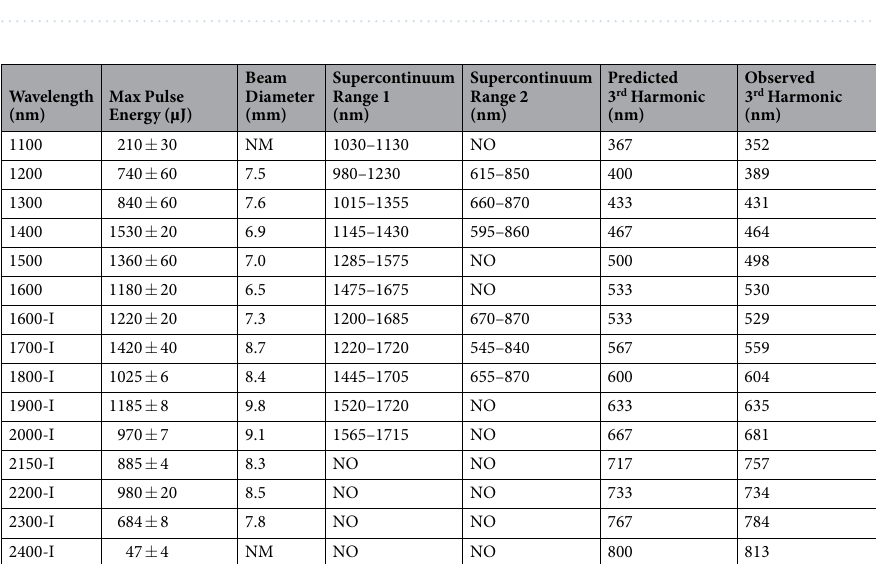
Table 2. Beam parameters for spectra generation. Wavelengths followed by “-I” were generated using the Idler beam. Acronyms: Not Measurable (NM), Not Observed